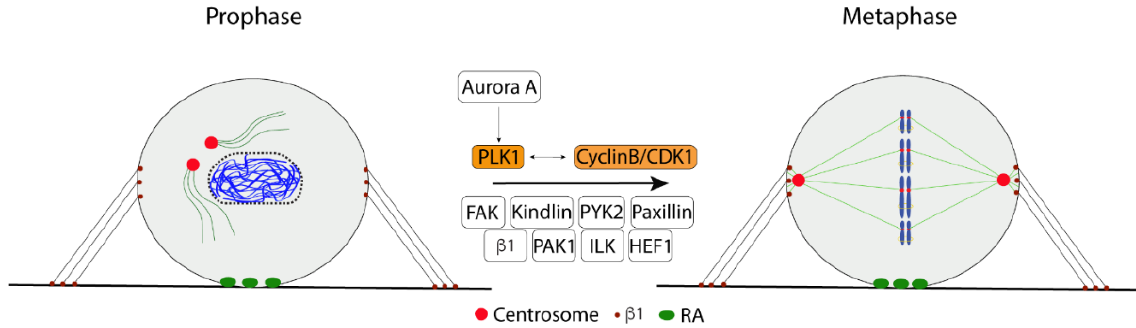
Figure 4. The components of CAs are involved in the cell cycle progression through the G2 phase and early mitosis where cyclin B/CDK1 and PLK1 play critical roles.